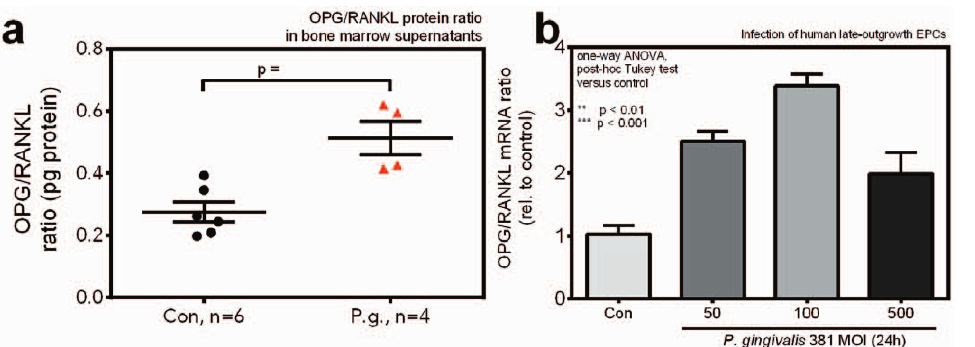
Figure 6. Increased osteoprotegerin/RANKL protein ratio within the bone marrow nice in P. gingivalis infected mice (a), increased osteoprotegerin/RANKL mRNA ratio in P. gingivalis infected late-outgrowth EPC invitro (b). Osteoprotegerin induces bone marrow cell retention and expansion, RANKL triggers mobilization. Increased osteoprotegerin/RANKL ratios may counter act a strong mobilization and depletion of bone marrow EPC. Data are presented as means 6 SEM, statistical testing was performed using an unpaired t-test (protein data) and ANOVA and post-hoc Tukey test (mRNA data). MOI, multiplicity-of-infection (ratio of prokaryotic/eukaryotic cells).